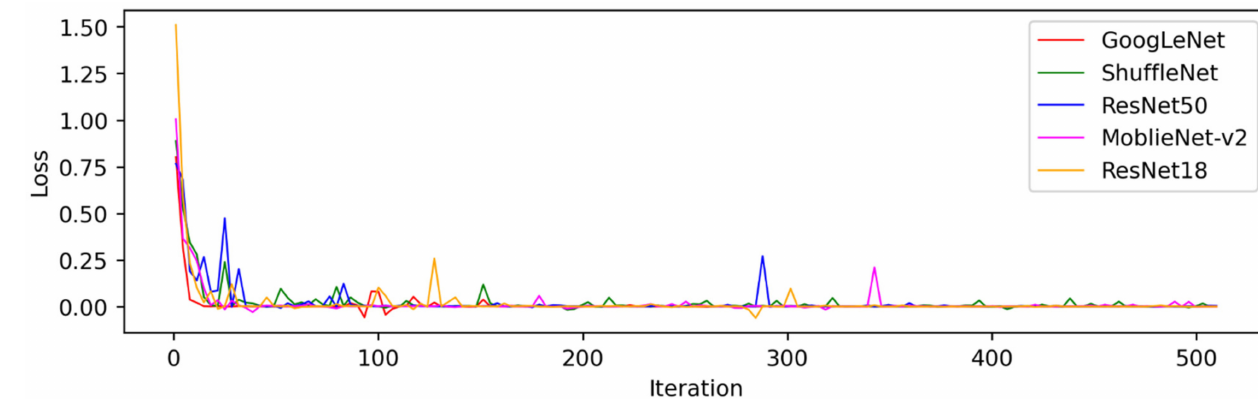
Figure 11. Comparison of training loss of recognition classification models.